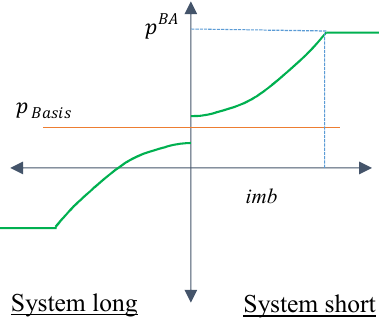
Figure 1. Balancing price formation (source: APCS, 2018, [26]).